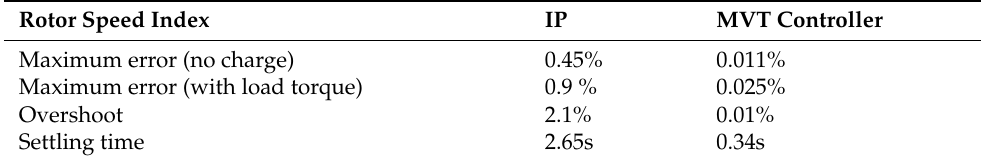
Table 1. Controllers